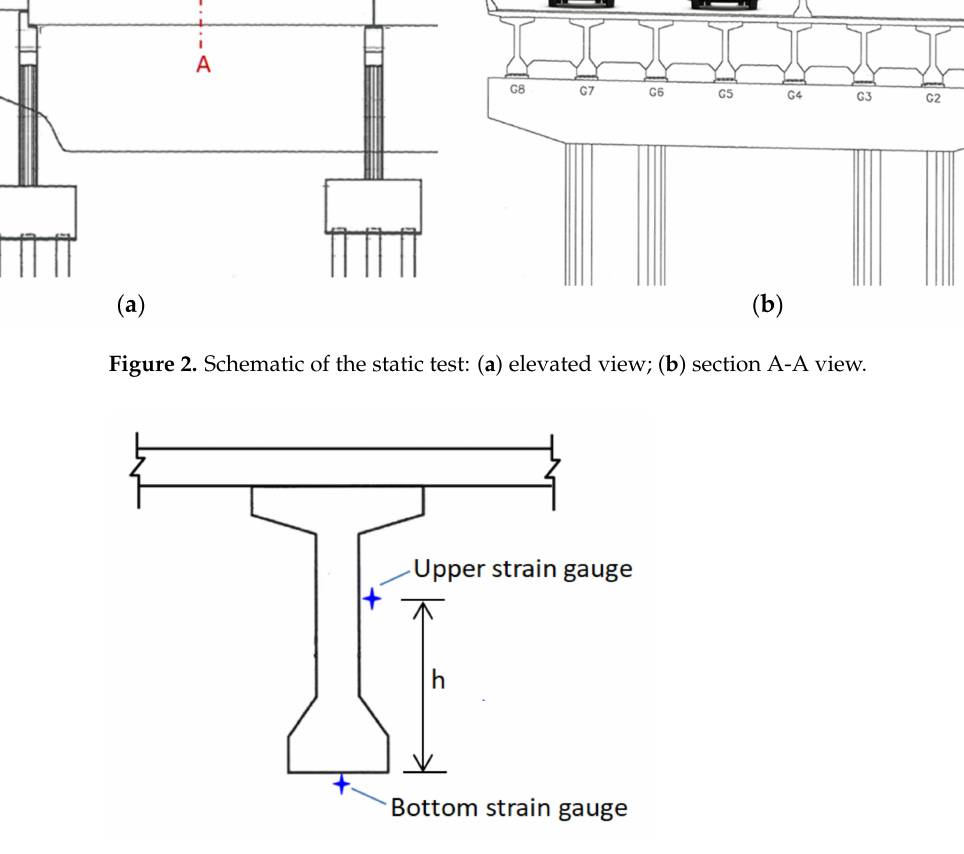
Figure 3. Schematic of the deployment of two strain gauges for the static